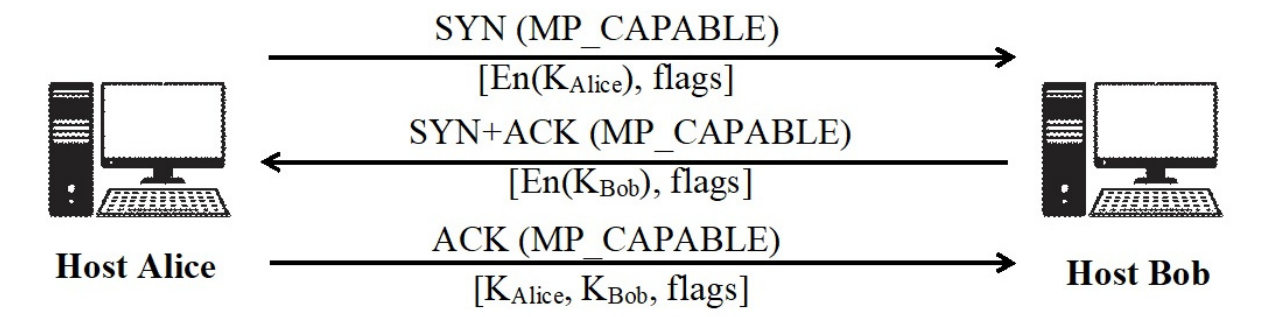
Figure 11. Three-way handshake with proposed scheme.